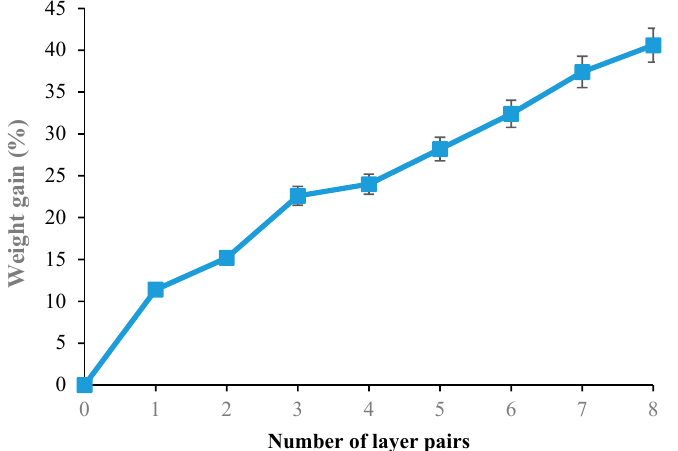
Figure 2. Weight gain variation as function of the number of layers grafted onto the cellulosic bio-sorbent material.